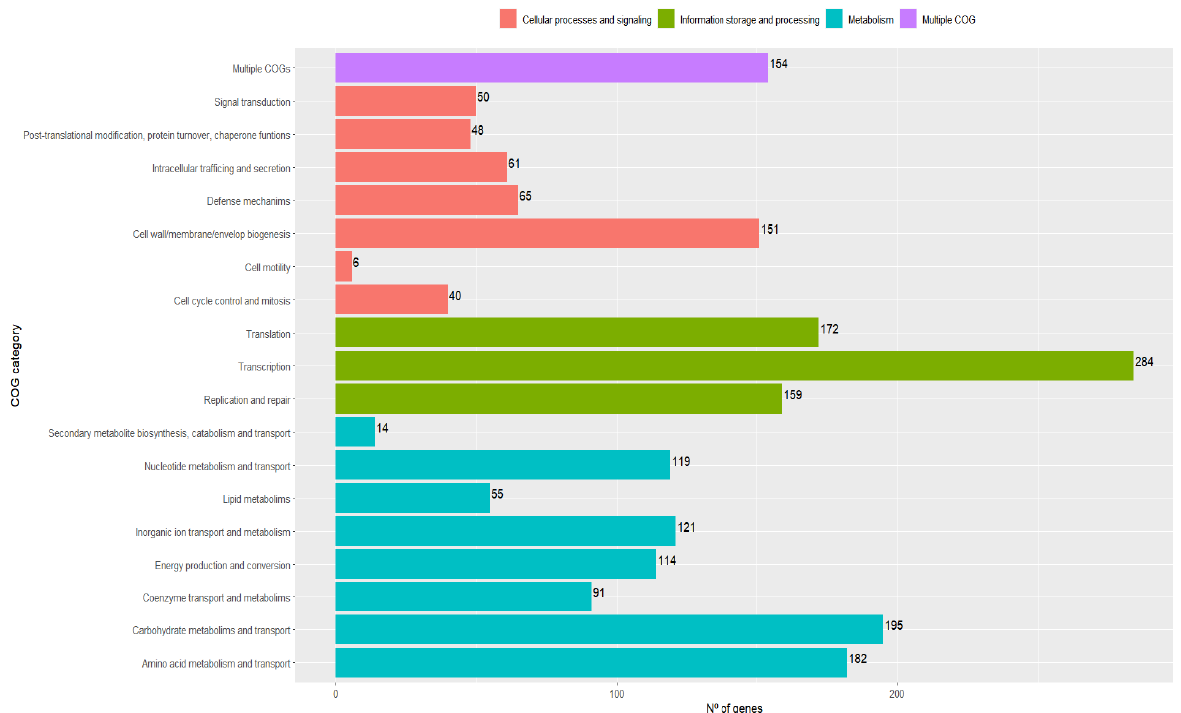
Figure 2. Functional classification into COG (clusters of orthologous groups) and the number of genes by categories of predicted CDSs of the LPG1 genome performed by EggNOGmapper. The genes with unknown functions and not associated with COG are not shown.